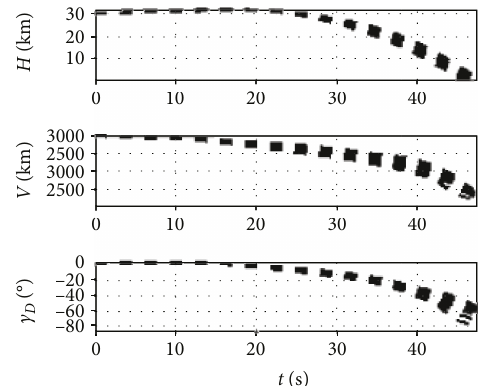
Figure 21: Curve representing the morphing rate.